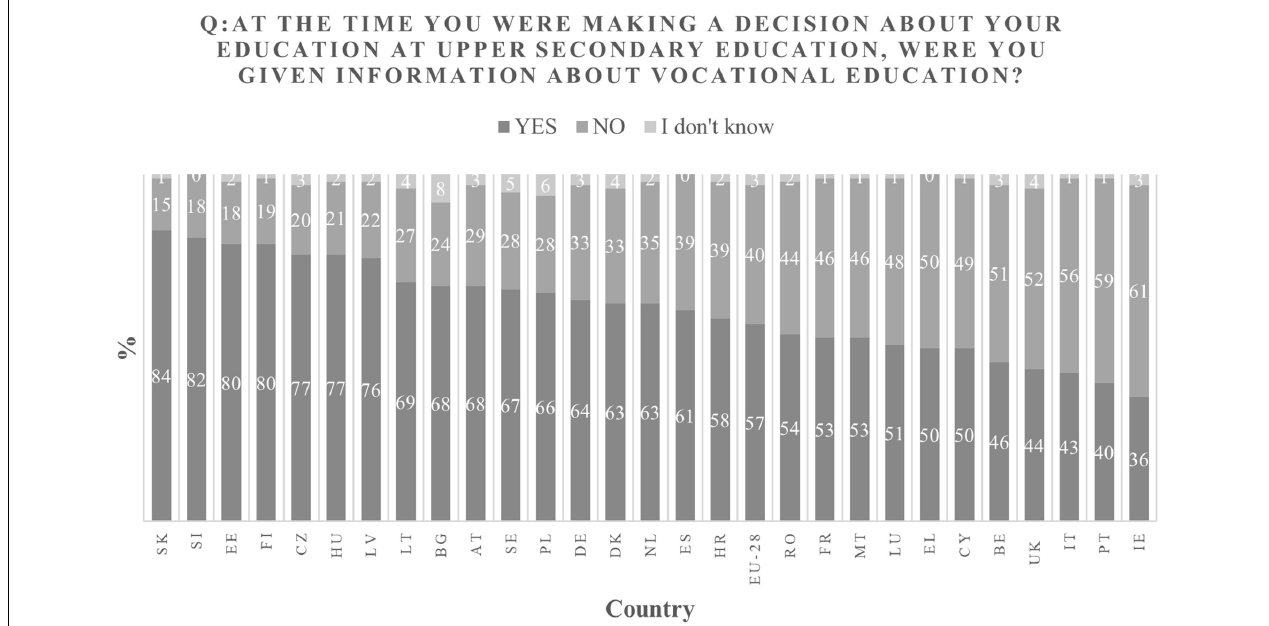
FIGURE 3 | Information on VET given to students by country. Note. Adapted from CEDEFOP (2017,